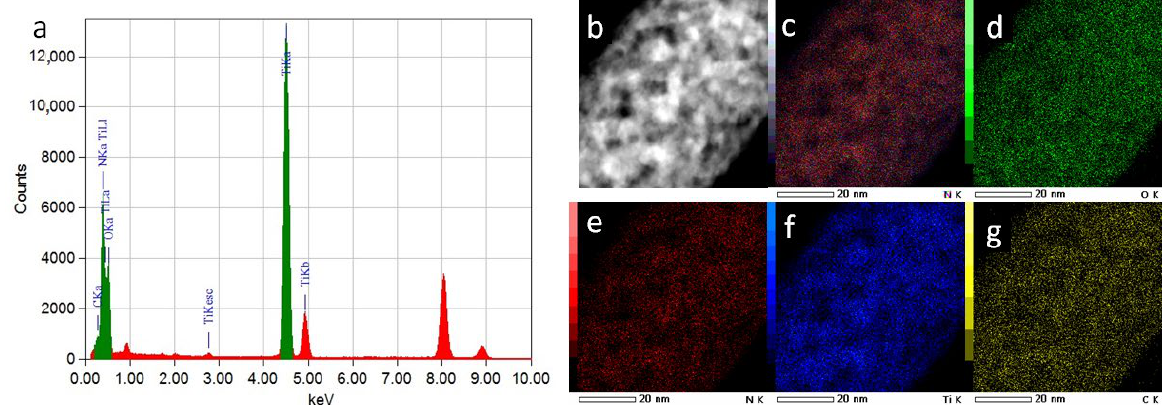
Figure 5. ( a ) STEM energy dispersive X-ray spectroscopy (EDXS) spectrum of the TiON/C-CNF2, ( b ) STEM-HAADF image of the TiON/C-CNF2 location for STEM EDXS analysis, ( c ) overlay image of images ( d – f ), ( d ) O elemental mapping image, ( e ) N elemental mapping image, ( f ) Ti elemental mapping image, ( g ) C elemental mapping image. Table 1. Composition of samples TiON/C-CNF1 and TiON/C-CNF2. The composition was obtained from SEM EDXS spectra in Figure